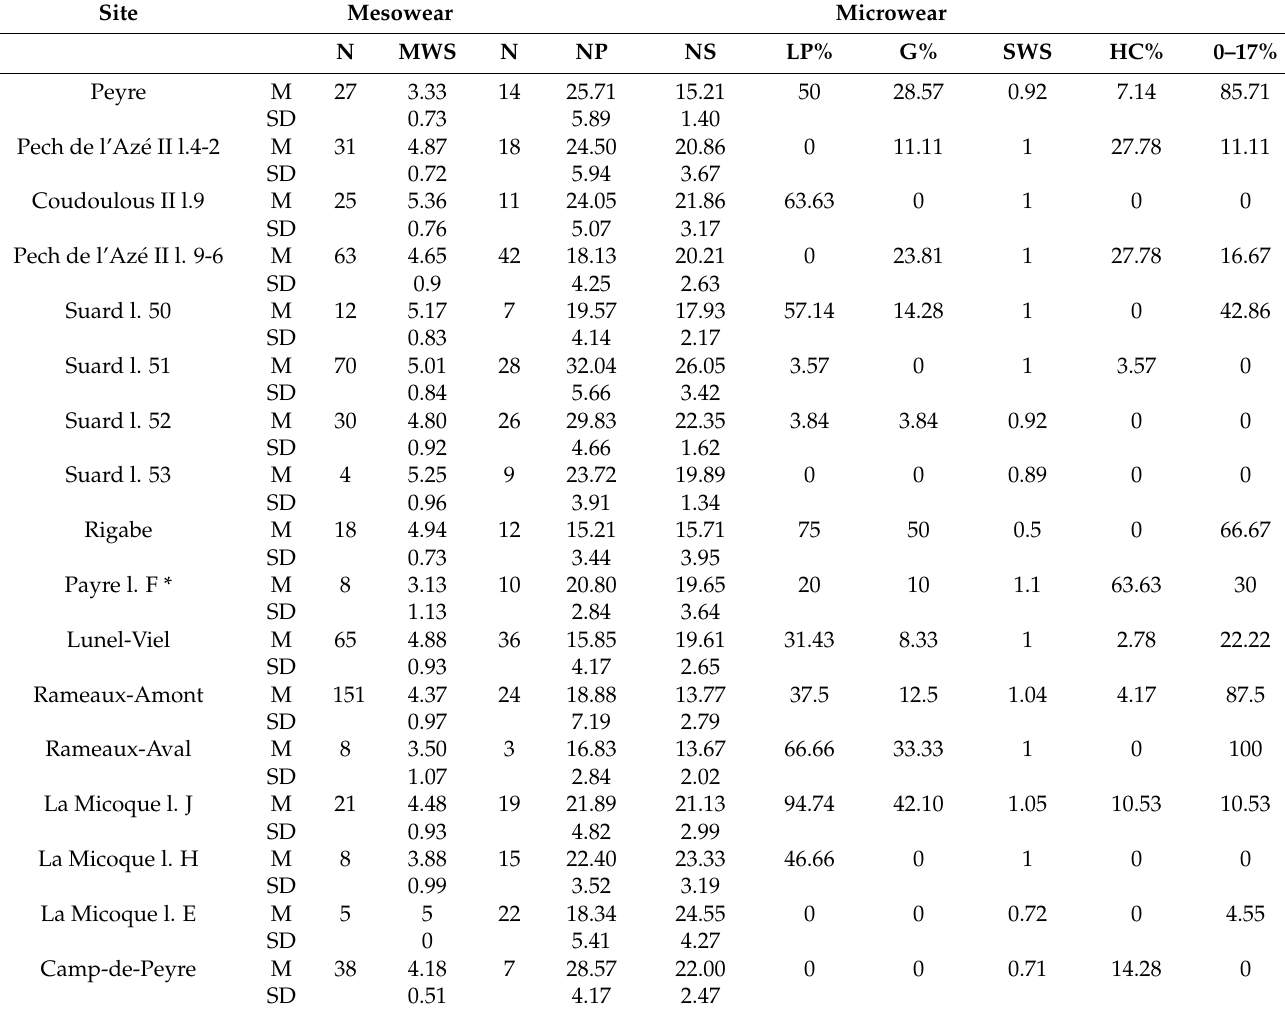
Table 5. Summary of the mesowear and microwear data for Pleistocene caballoid Equus from the South of France. Abbrevia- tions: N = number of specimens; MWS = mesowear score; NP = average number of pits; NS = average number of scratches; LP% = percentage of specimens with large pits; G% = percentage of specimens with gouges; SWS = scratch width score; HC% = percentage of specimens with hypercoarse scratches; 0–17% = percentage of specimens with 17 or fewer scratches per counting area. M = average; SD = standard deviation. * Comm pers. F. Rivals. Camp-de-Peyre: E. m. campdepeyri